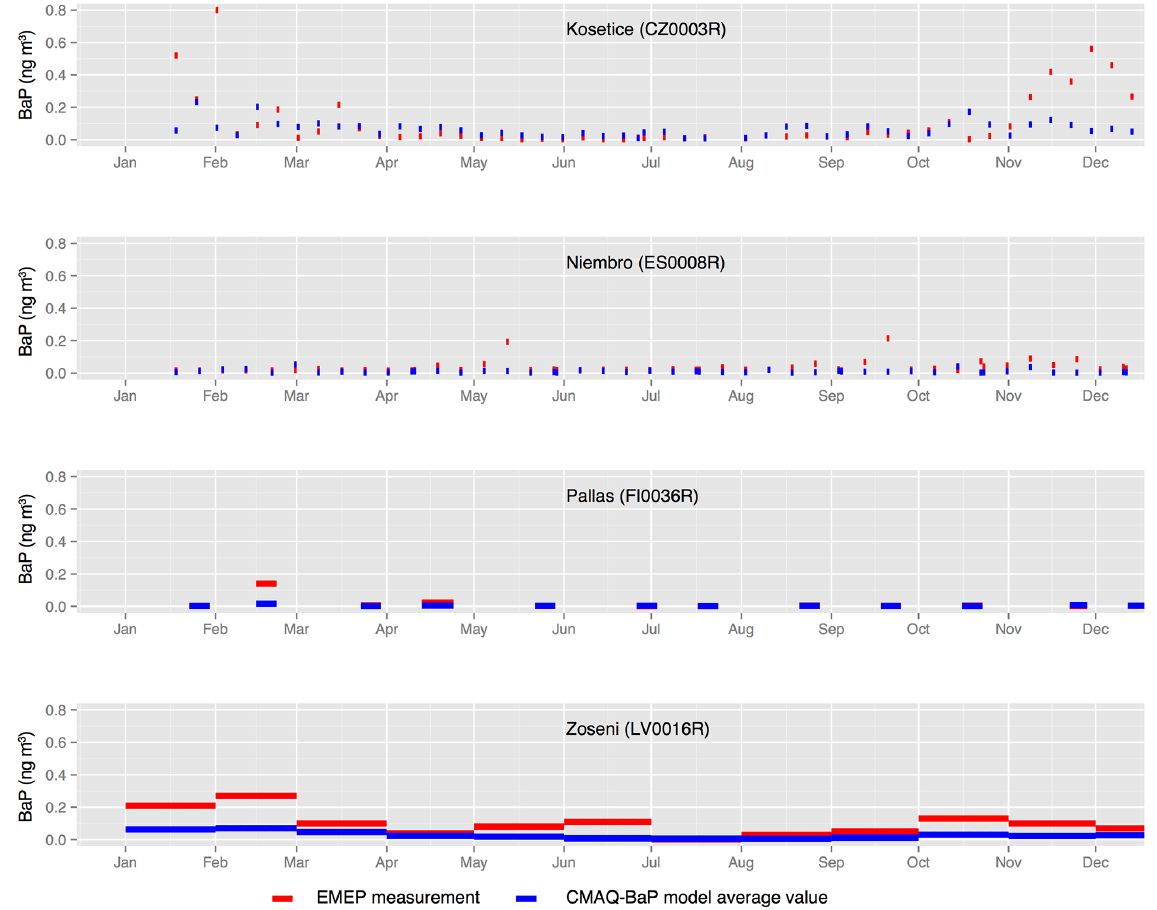
Figure 7. Model predicted and observed concentration (ngm − 3 ) time series at selected EMEP monitoring sites during 2006 for the dual GPP model scenario